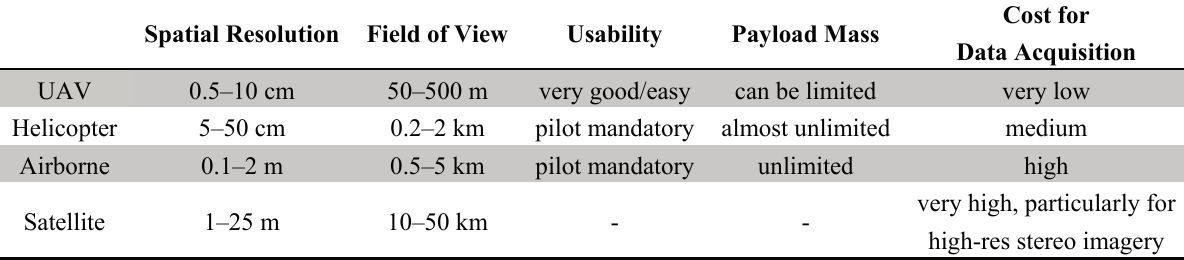
Table 1. Comparison of UAV with other manned airborne and satellite platforms